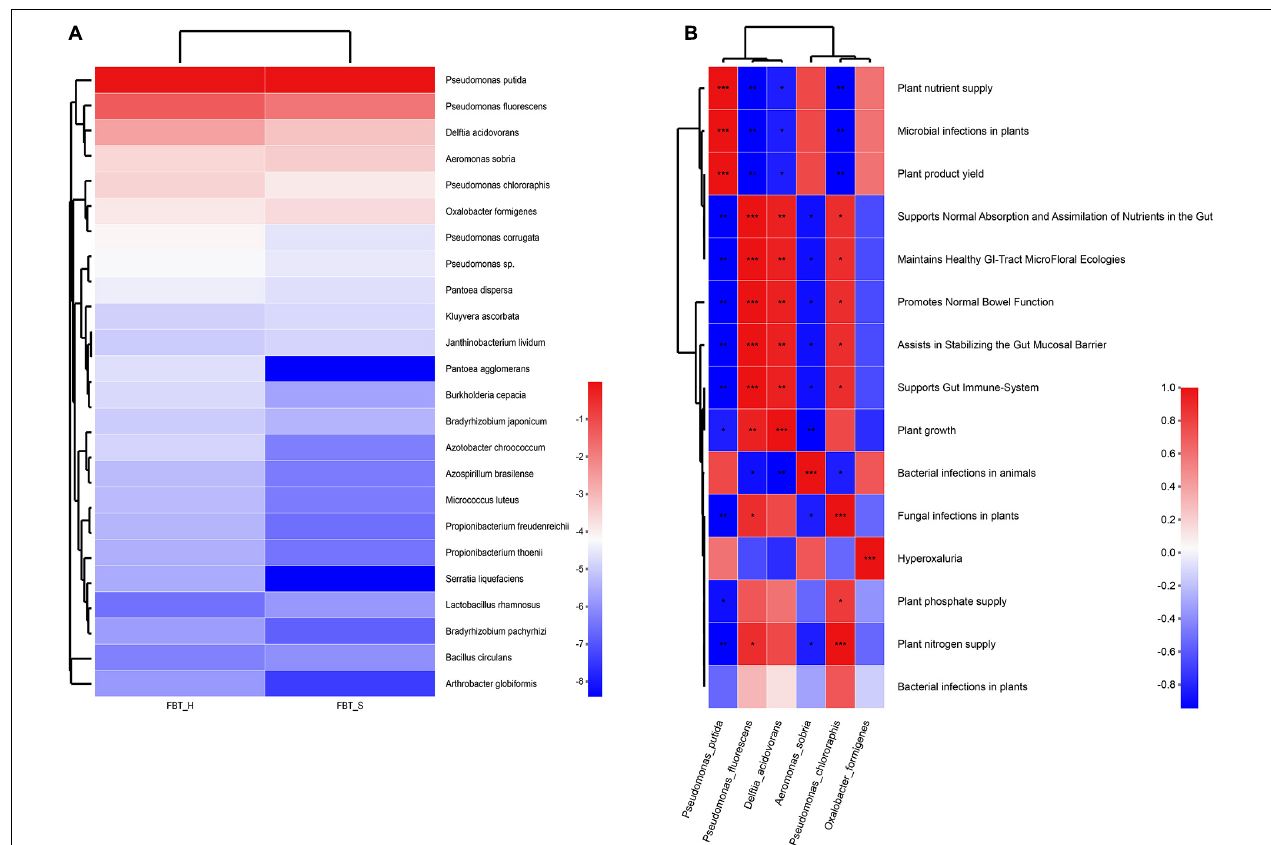
FIGURE 8 | Probiotic analysis for FBT communities against probio database. (A) The relative abundances of inferred probiotic in FBT communities. (B) Correlation between probiotic and functional abundances (* p < 0.05, ** p < 0.01, and *** p < 0.001). Cell colors indicate the correlation coefficients based on the scale to the